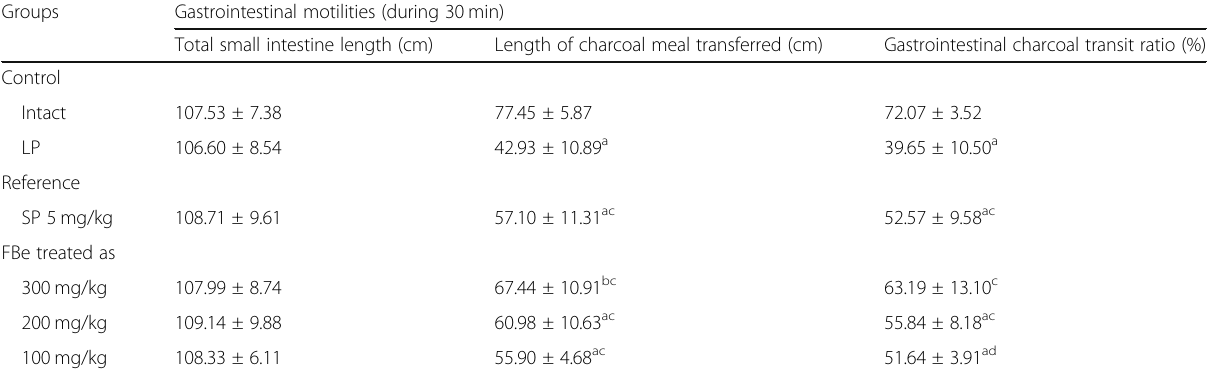
Table 4 Gastrointestinal charcoal transit ratio in the constipation rats induced by LP Groups Gastrointestinal motilities (during 30 min)